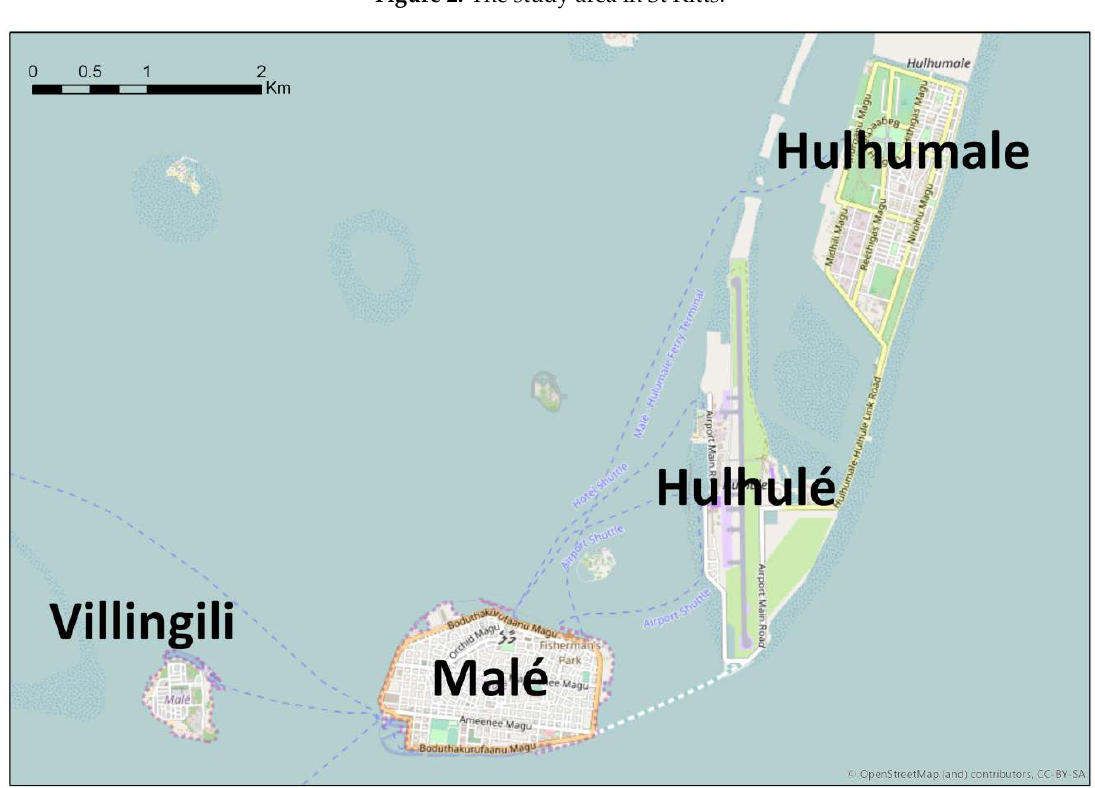
Figure 3. The study area around Mal é